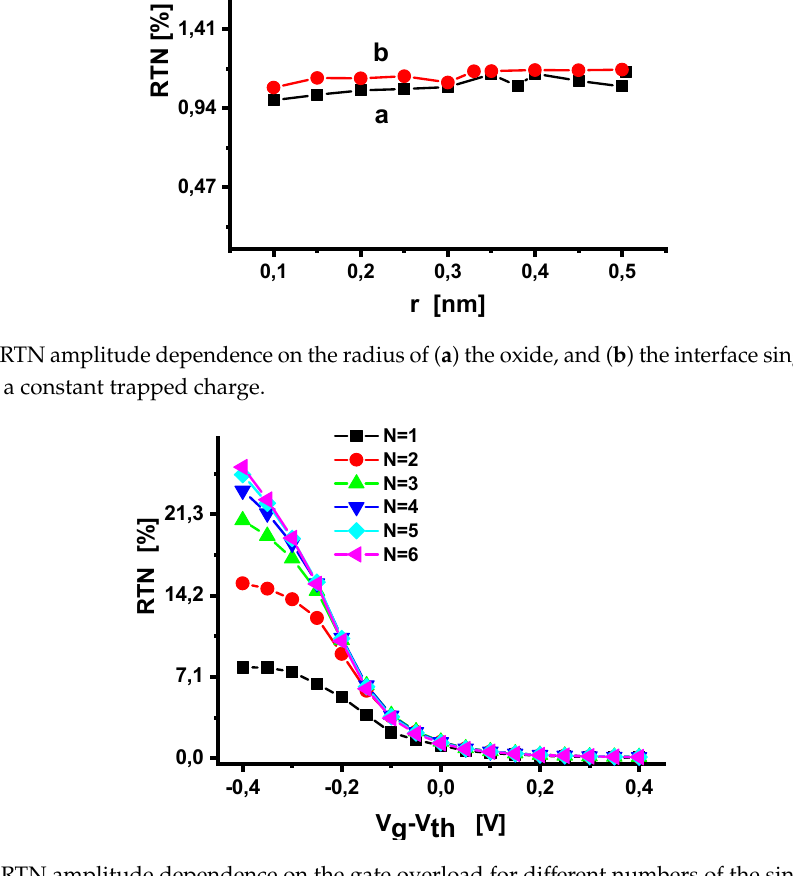
( b ) Figure 9. RTN amplitude dependence on the number of the single charge trapped in the defect area at gate overload 0 V ( a ) and − 0.4 V ( b ). 4. Conclusions We have found out that the RTN amplitude in a Junctionless FinFET does not actually depend on the single charge spatial distribution in the defect. A simplified simulation of the single trap can be modeled by the homogeneously charged simple cells in both the oxide and interface trap cases. Moreover, the RTN amplitude does not practically depend on the linear size of the charged area in the range from 0.1 up to 0.5 nm. However, the RTN amplitude is considerably increased with the increasing number of single charges trapped in the defect. In particular, a high amplitude is created at the subthreshold region, depending on the number of the trapped charge. Author Contributions: Conceptualization, A.E.A., A.Y.; methodology, A.E.A., M.M.K.; software, M.M.K.; validation, A.E.A. and M.M.K.; formal analysis, A.J.G.-L.; investigation, M.M.K.; resources, M.M.K.; data curation, M.M.K.; writing—original draft preparation, A.E.A.; writing—review and editing, K.K. and J.C.C.;